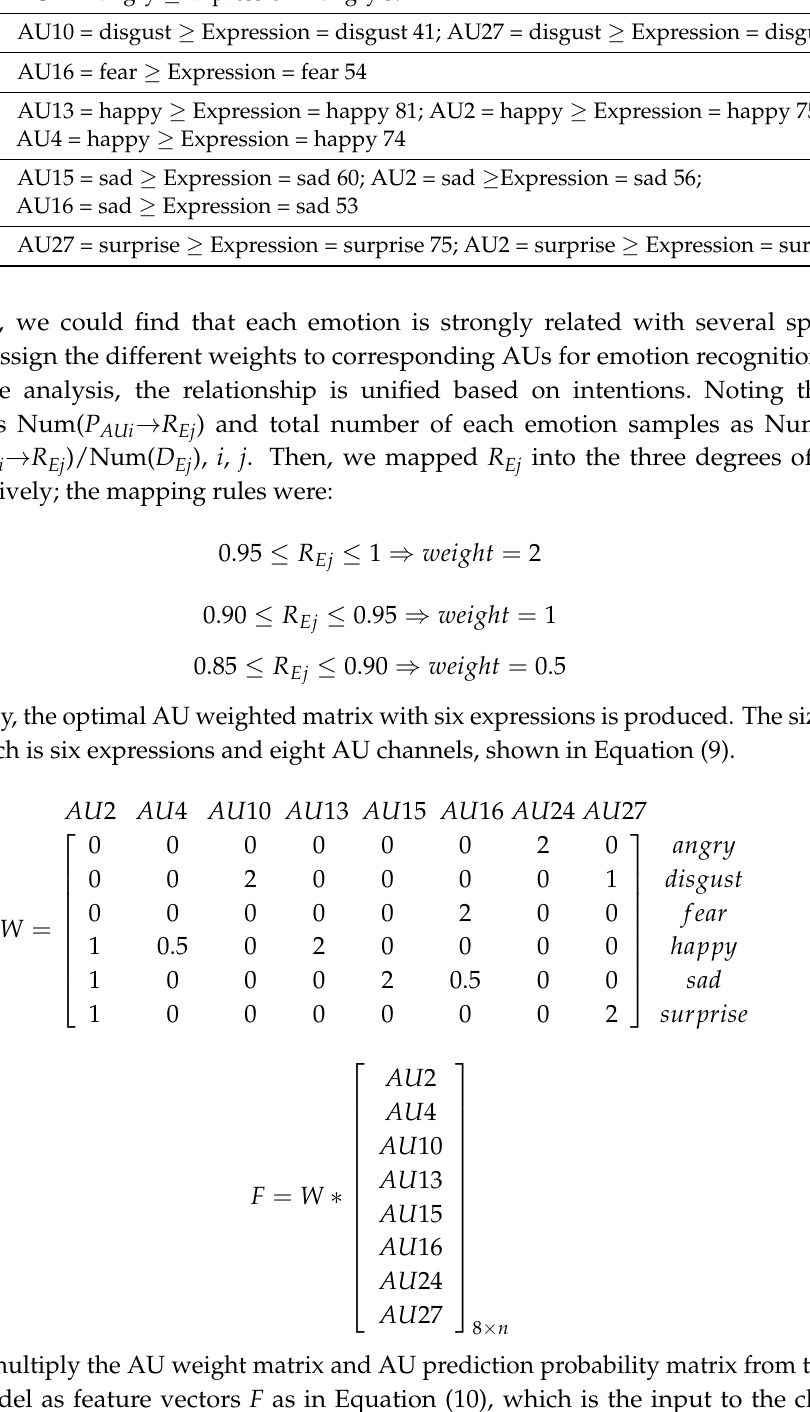
Table 5. The result of association about AU and simple expression based a priori. Expression Association Rules of